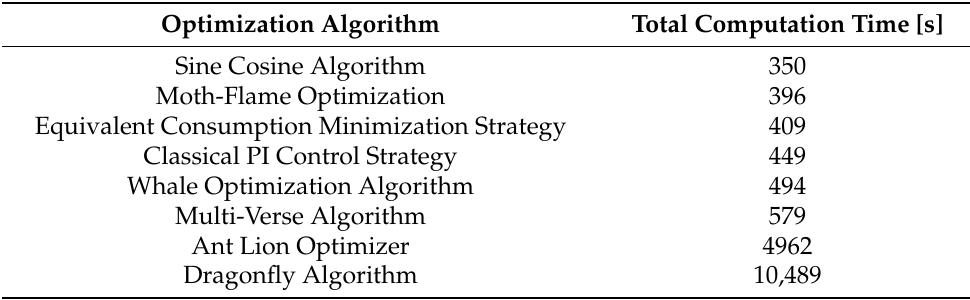
Table 6. Comparison of optimization algorithms in terms of total computation time (simulation type: discrete; sample time: 0.0001 s).